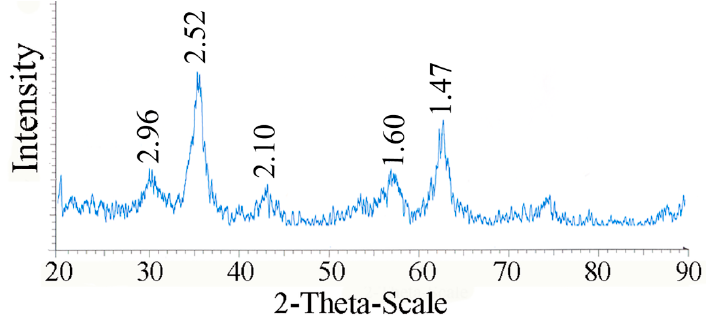
Figure 5. X-ray power diffraction patterns of L -lysine coated magnetite nanoparticles.